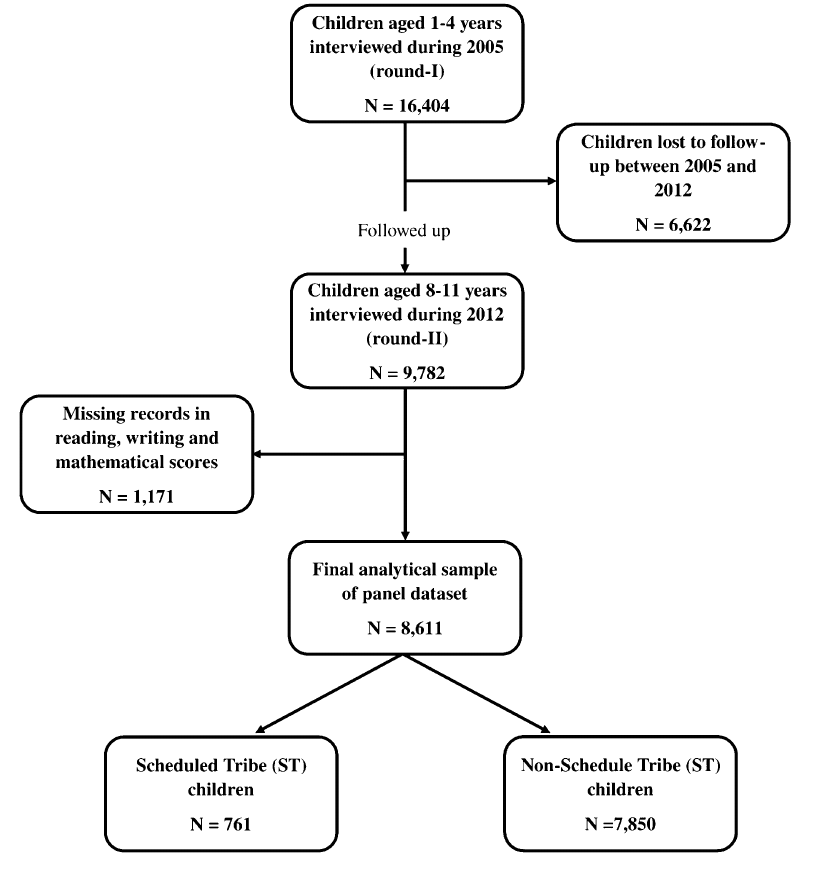
Figure 1. Flowchart demonstrating analytic sample based on IHDS round I (2005) and round II